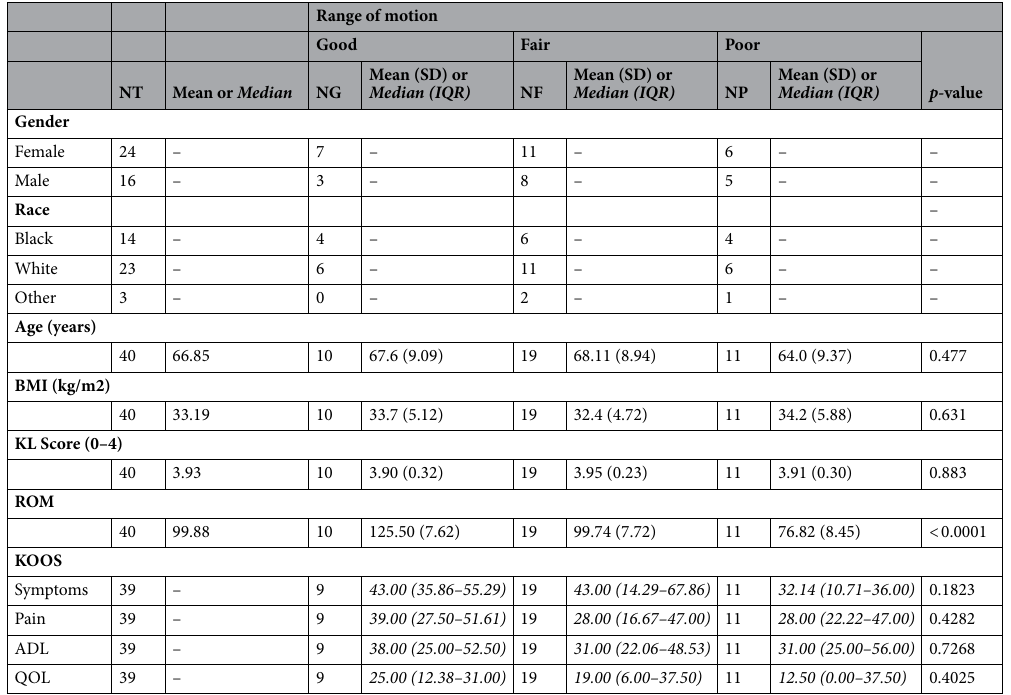
Table 1. Patient characteristics. Distribution of study participants by gender, race, and mean age, BMI, KL radiographic scores, KOOS and ROM for the total patient sample (n=40) or grouped by ROM status tested by one-way ANOVA or Kruskal-Wallis using Graphpad PRISM 9, in which p < 0.05 is significant. NT = total patient sample; NG = good ROM group; NF = fair ROM group; NP = poor ROM